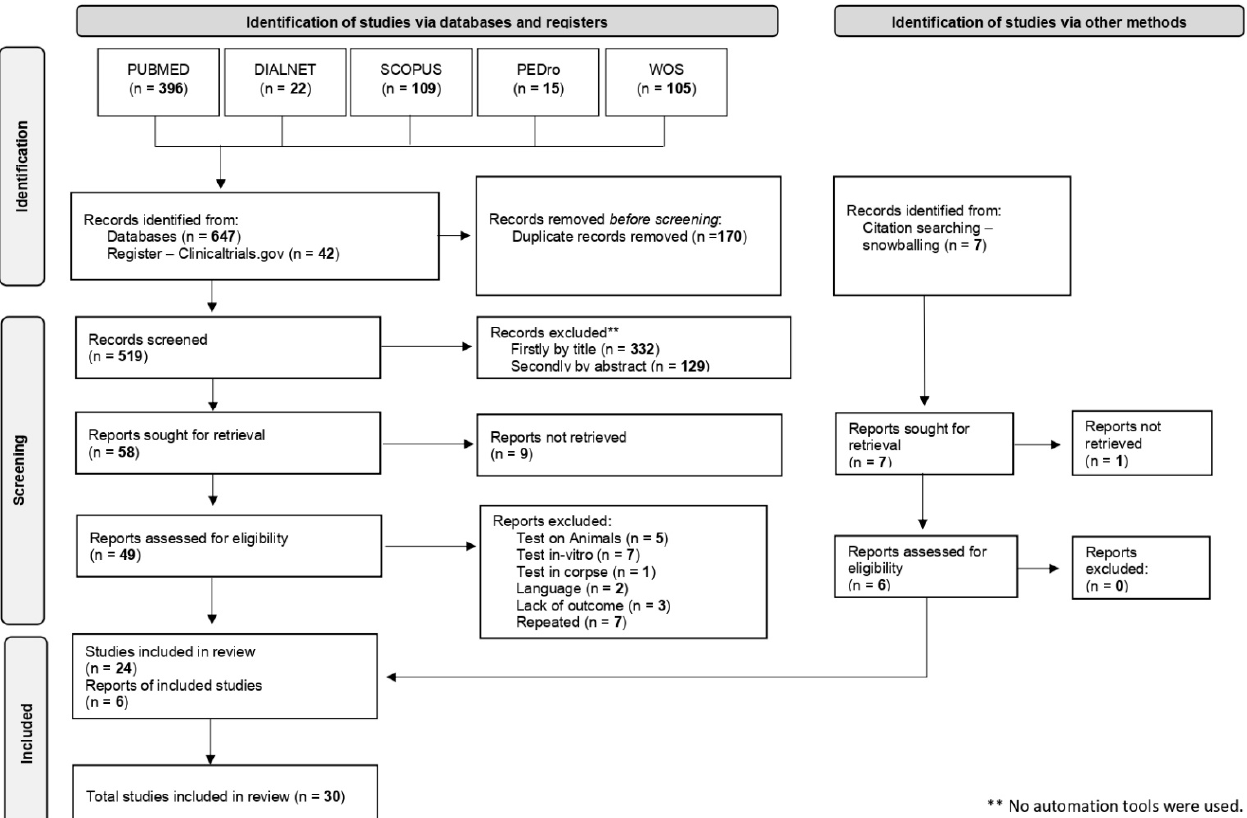
Figure 1. Flowchart showing the article selection process conducted by this review.